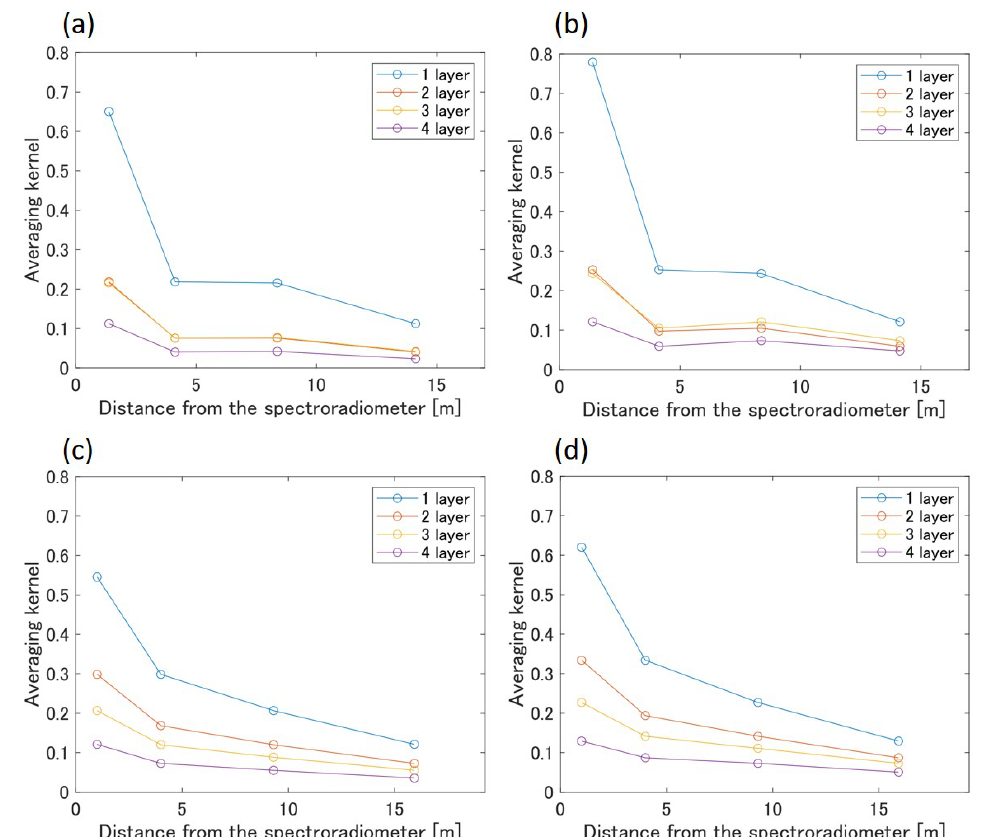
Figure 10. Averaging kernel considered in the study. The MAP solution consists of both the observed air temperature distribution and prior information, with a higher value of the averaging kernel indicating a higher weight from the observed air temperature distribution. ( a ) Cases A1 and A3, ( b ) cases A2 and A4, ( c ) cases B1 and B3, and ( d ) cases B2 and